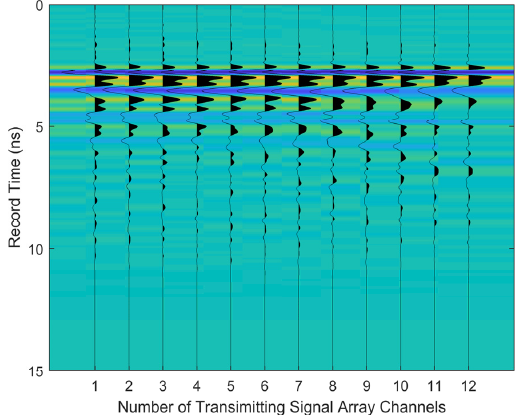
Figure 5. Corresponding emission signals from 12 Vivaldi antennas.